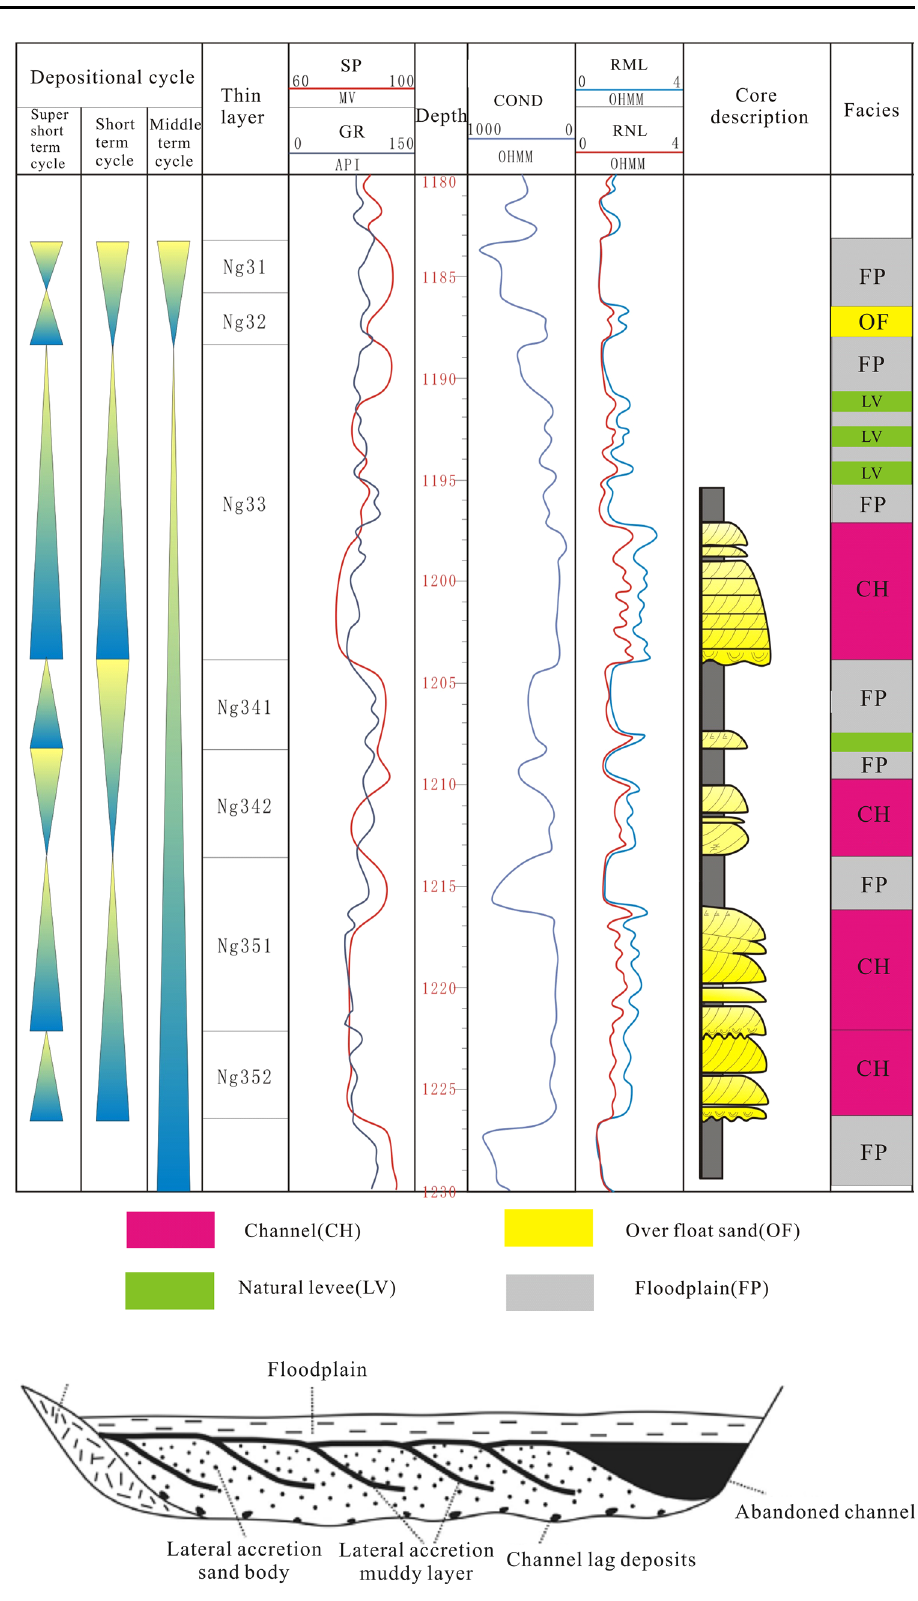
Fig. 2 Division of sedimentary cycles and the interpretation of meandering river architecture units in well 13XJ9 in Gudao Oil field